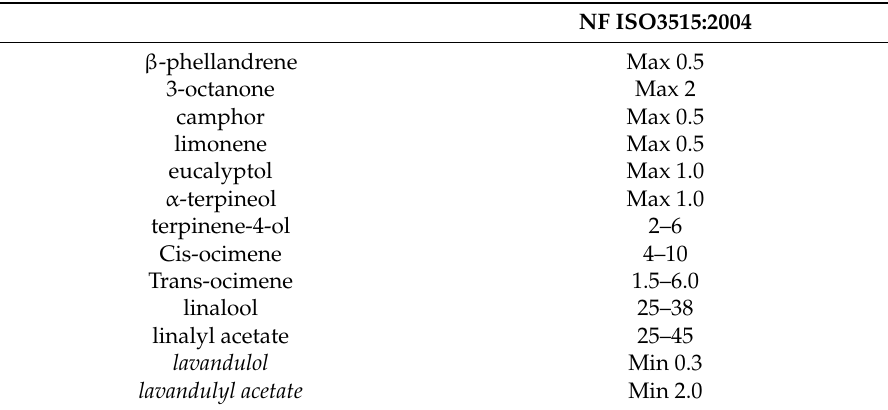
Table 1. International standards for the oil of Lavandula angustifolia Miller (norm for population lavender, i.e., lavender grown exclusively from seed, spontaneous or cultivated mainly in the south of